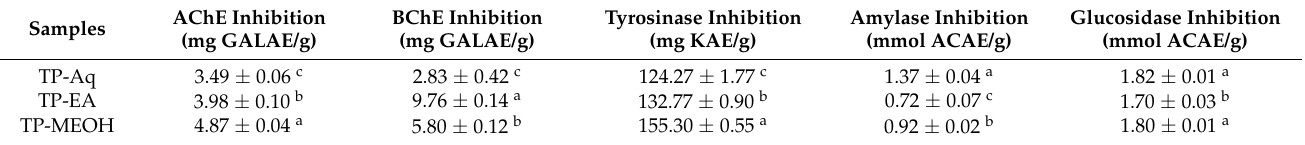
Table 5. Enzyme inhibitory potential of the